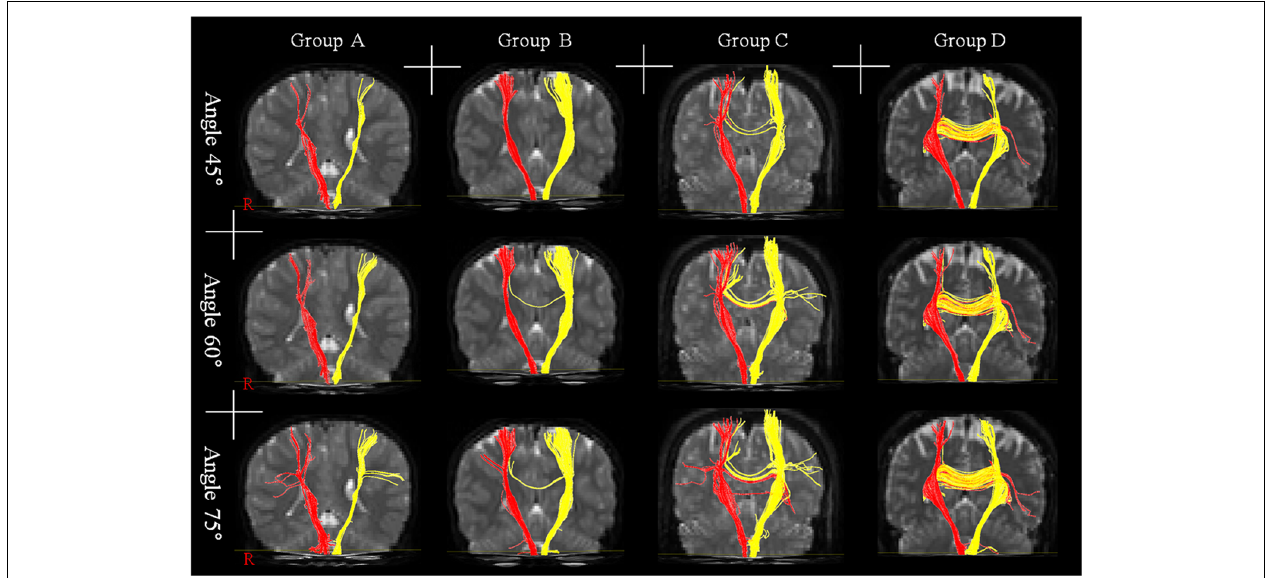
FIGURE 1 | Results of diffusion tensor tractography for transcallosal motor fiber originating from the corticospinal tract with three angles: groupA – the range of age was 0–5 years, group B – the range of age was 6–10 years, group C – the range of age was 11–15 years, and group D – the range of age was 16–20